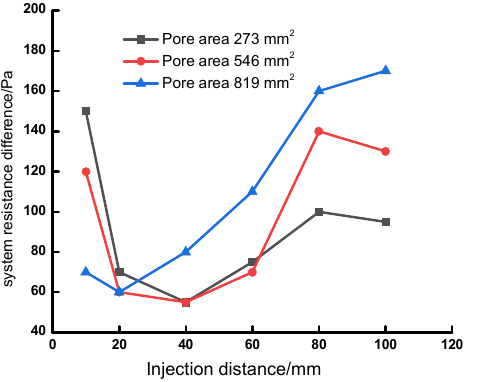
Figure 8. The system operation resistance difference of the cartridge with different.